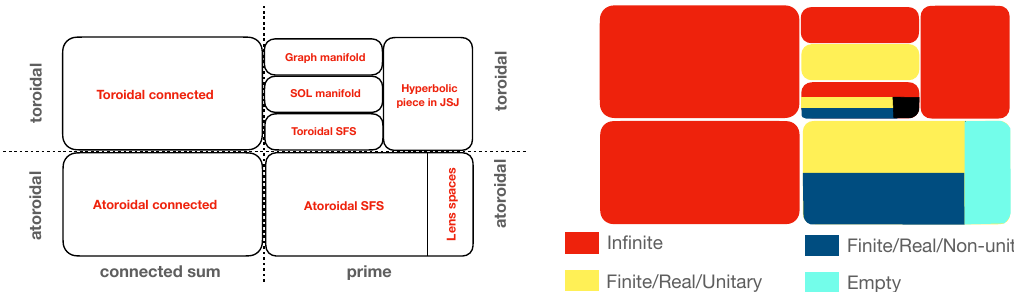
Figure 1 . Two classifications of closed non-hyperbolic 3-manifolds: (Left) according to the existence of essential 2-sphere or 2-torus and (Right) based on the properties of 3D index and SL(2 , C ) irreducible flat connections on the 3-manifolds. The relation between two classifications are illustrated in the two diagrams. The 3-manifolds of finite/complex types are always hyperbolic and thus do not appear here. Among prime/torodial 3-manifolds, it is of finite type if all essential tori are non-separating and of infinite type otherwise. The 3-manifolds of infinite type can be further divided into two categories depending on whether it is real or complex but the refined division is not drawn in the diagram. Among toroidal SFS, toroidal 3-fibered Seifert-spaces, i.e. S 2 (( p )( p )( p )) 1 , q 1 2 , q 2 3 , q 3 q i with P = 0 and P 1 = 1 , are of finite and real while Σ 1 are of infinite type. We could g> 1 × S i p i p i not fully identify the type of other toroidal SFS and leave them in a black color. SOL manifolds are always finite/real/unitary while S 2 (( p )( p )( p )) could be either finite/real/unitary or 1 , q 1 2 , q 2 3 , q 3 finite/real/non-unitary as in